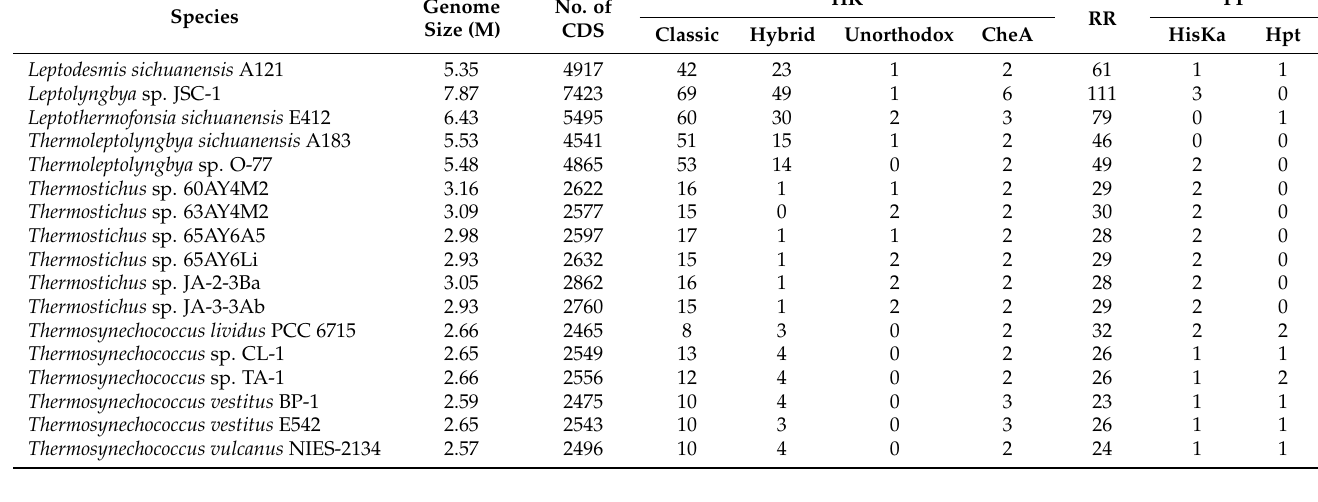
Table 1. Summary of putative TCS genes in thermophilic cyanobacteria studied. Species